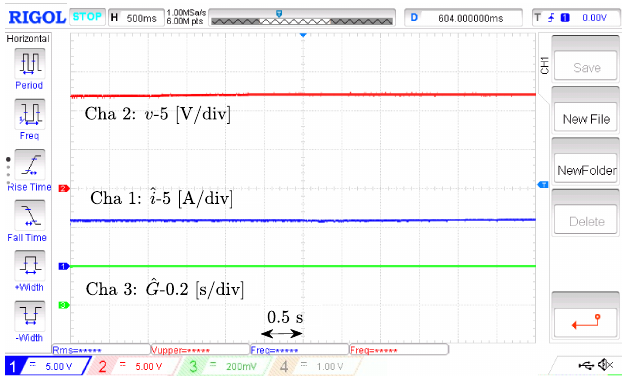
Figure 7. The operation curves of boost converter under the proposed